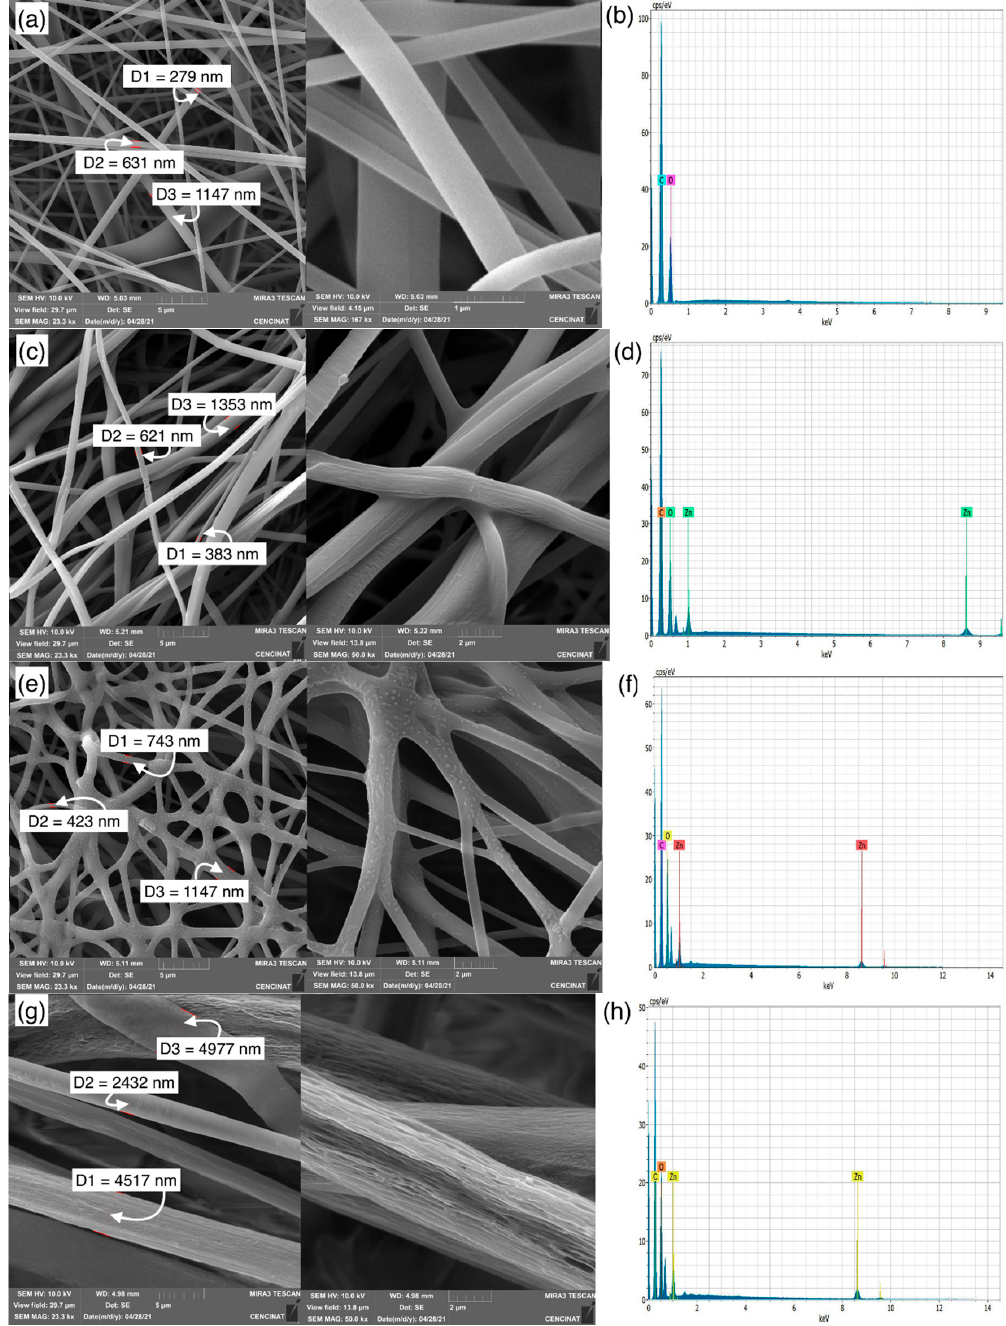
Figure 2. SEM analysis and EDS spectrum of samples: ( a ) and ( b ) r-PET; ( c ) and ( d ) ZnO-1.5/r-PET; ( e ) and ( f ) ZnO-3/r-PET; ( g ) and ( h ) ZnO-6/r-PET, respectively.